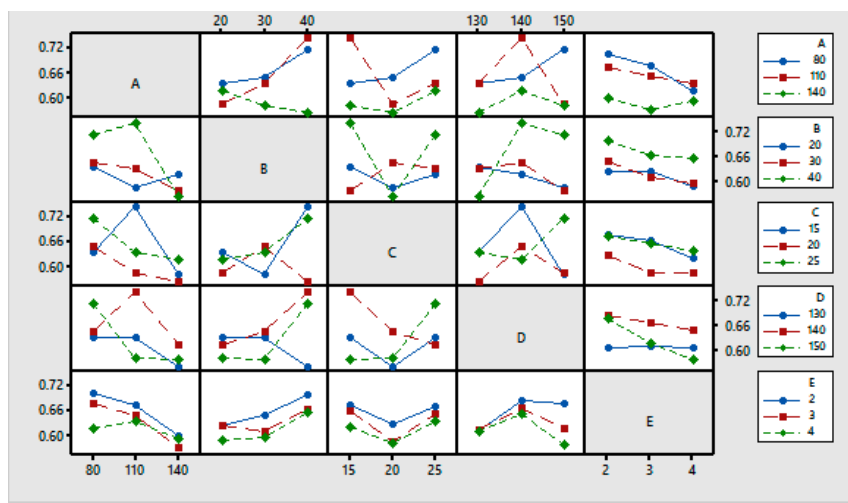
Figure 6. Interaction plots for the means [Response: GRG]. Table 13. ANOVA for the GRG.